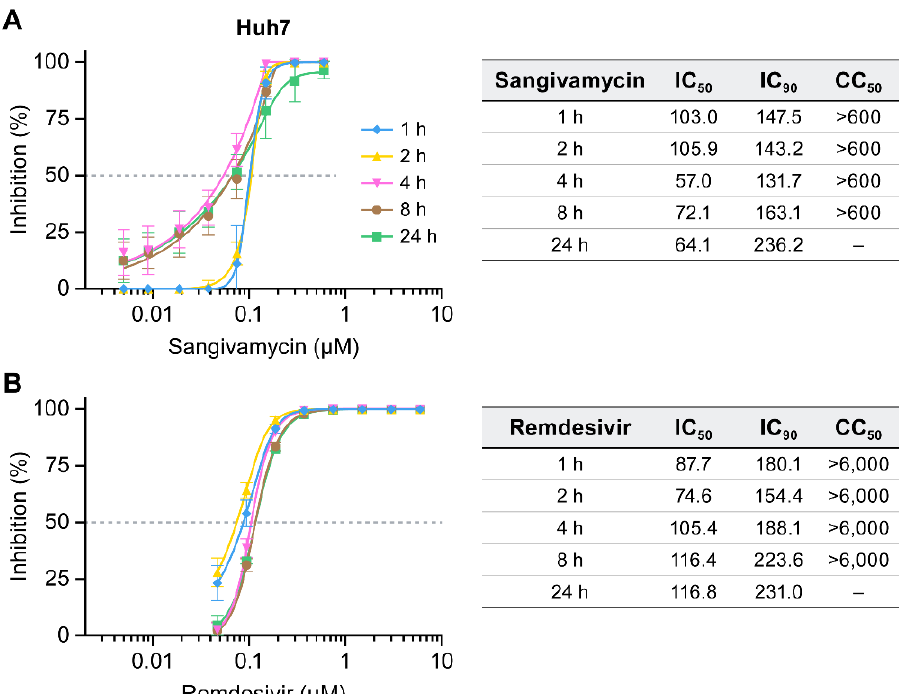
Figure 6. Sangivamycin inhibits EBOV up to 24 h after addition relative to virus exposure. Huh7 cells were infected with EBOV and sangivamycin ( A ) or remdesivir ( B ) were added to the cells at 1, 2, 4, 8 and 24 h after virus exposure. Results are reported as percent inhibition and cytotoxicity relative to untreated controls. Each concentration was run in triplicate.